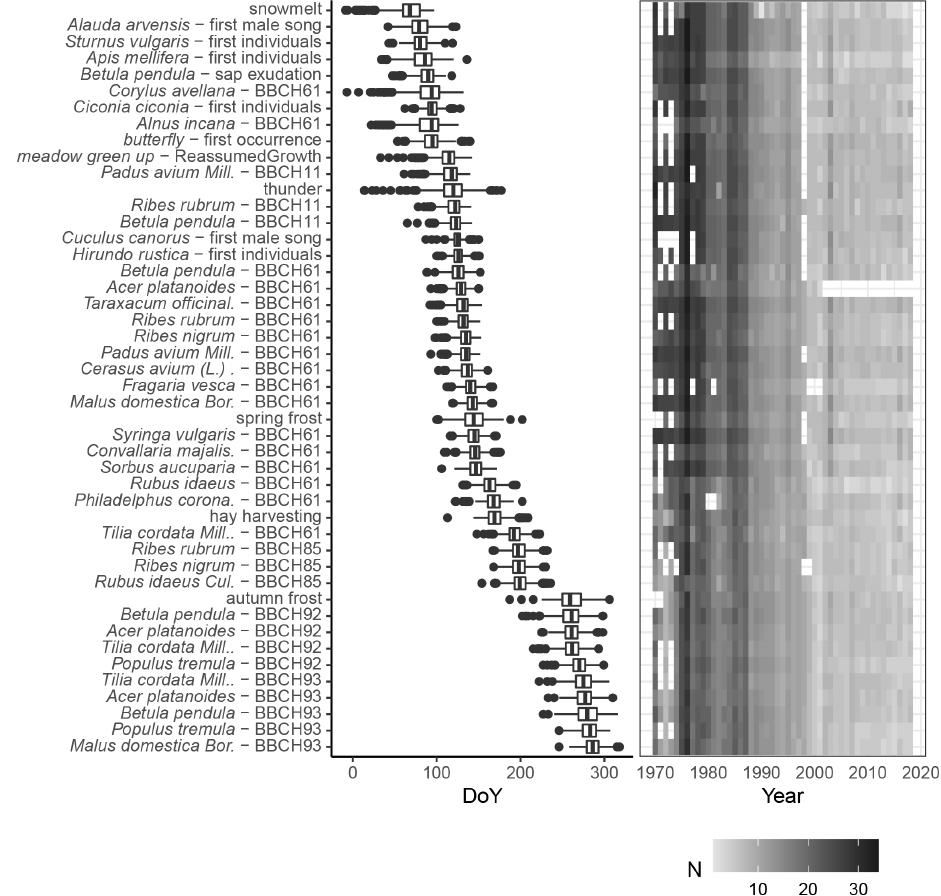
Figure 7. Phenological calendar for Latvia – chronological sequence of phenological phases. Phases selected with > 500 observations, plotted as a boxplot, where the median value is the vertical line, the sides of the boxplot are corresponding 25th and 75th quartiles, the whiskers extend to 1.5 times the distance between the first and third quartiles, and the dots are any remaining outliers. The right panel shows the number of observations per